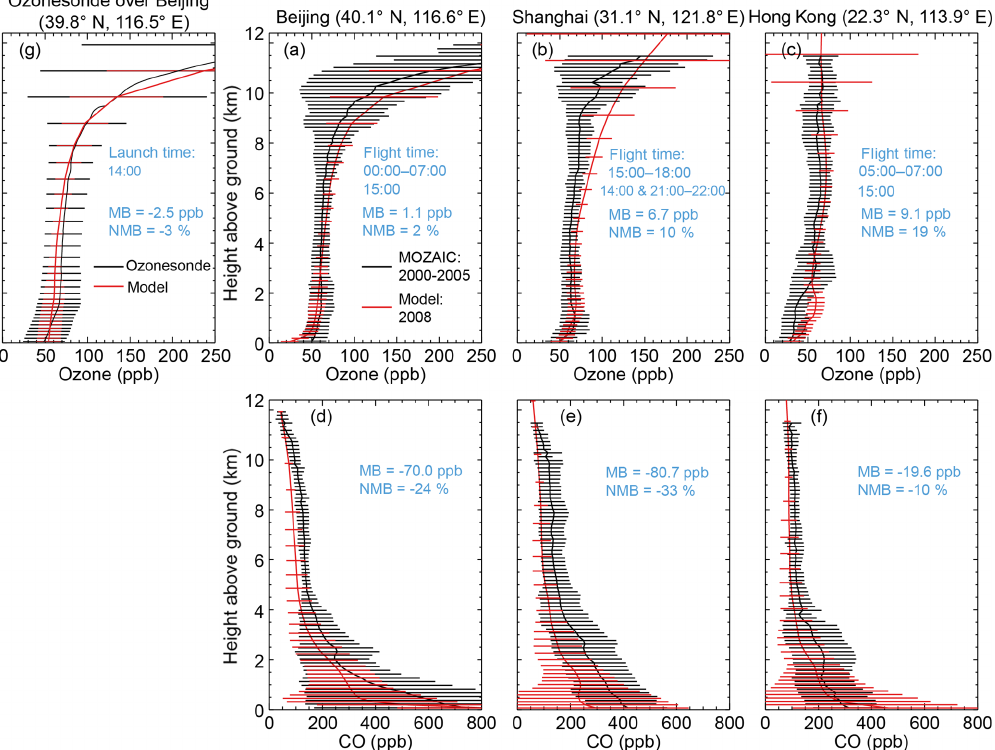
Figure 6. Model and MOZAIC vertical profiles of (a–c) ozone and (d–f) CO over airports of Beijing, Shanghai, and Hong Kong, averaged over multiple profiles. (g) Model and GPSO3 ozonesonde data over Beijing in spring 2008. Horizontal bars indicate 1 standard deviation across multiple profiles. Mean bias (MB), normalized mean bias (NMB), main fight times (local time) at each MOZAIC site, and GPSO3 ozonesonde launch time (local time) are also